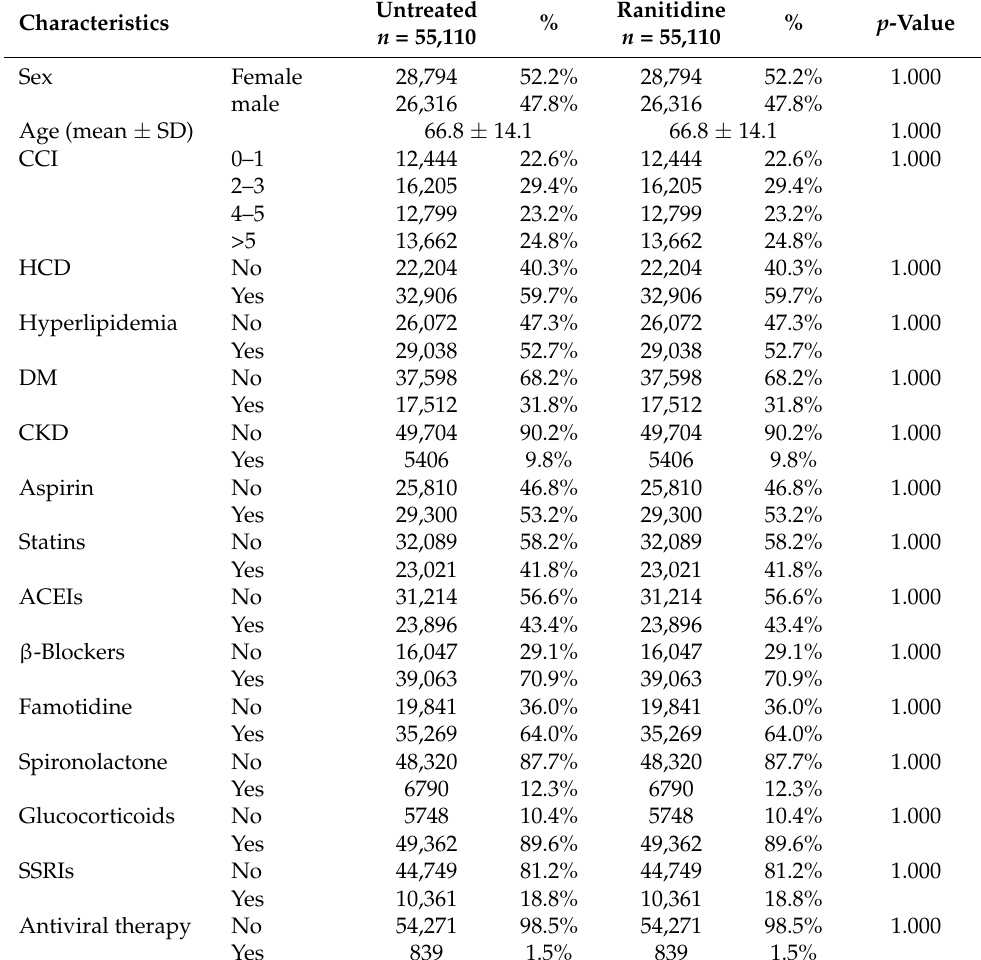
Table 1. Baseline characteristics of the non-ranitidine cohort and ranitidine cohort with over 90 DDDs.